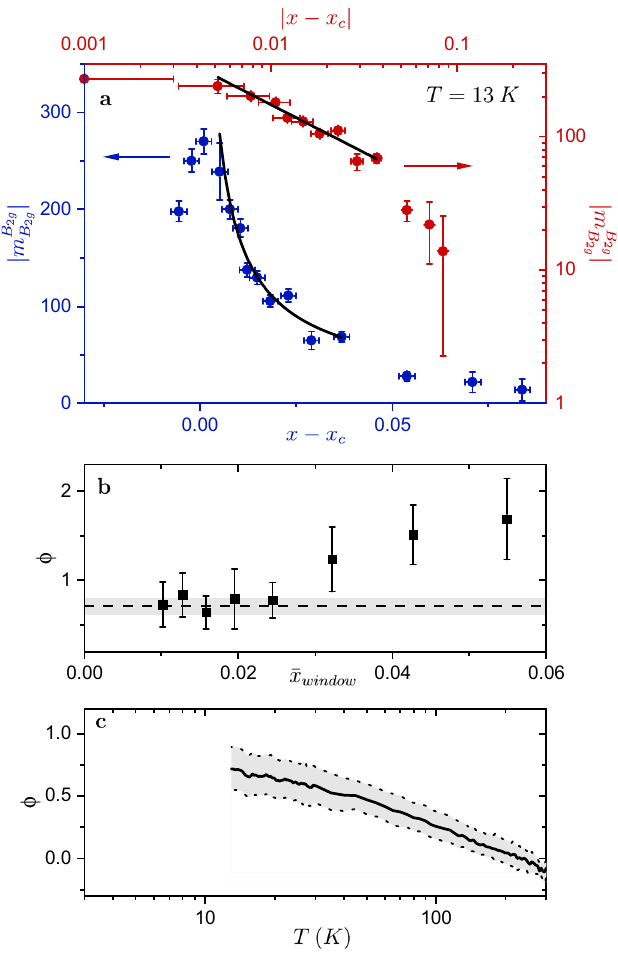
described by a power law over the whole temperature